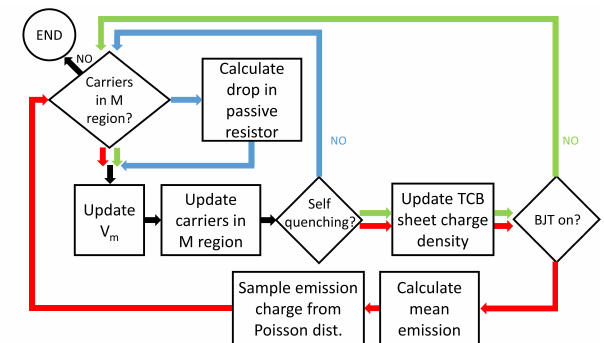
Figure 14: Flowchart for Monte Carlo simulation of carrier dynamics for passively quenched (blue), self-quenched (green), and MAGIC (red) detectors. Adapted from [34].